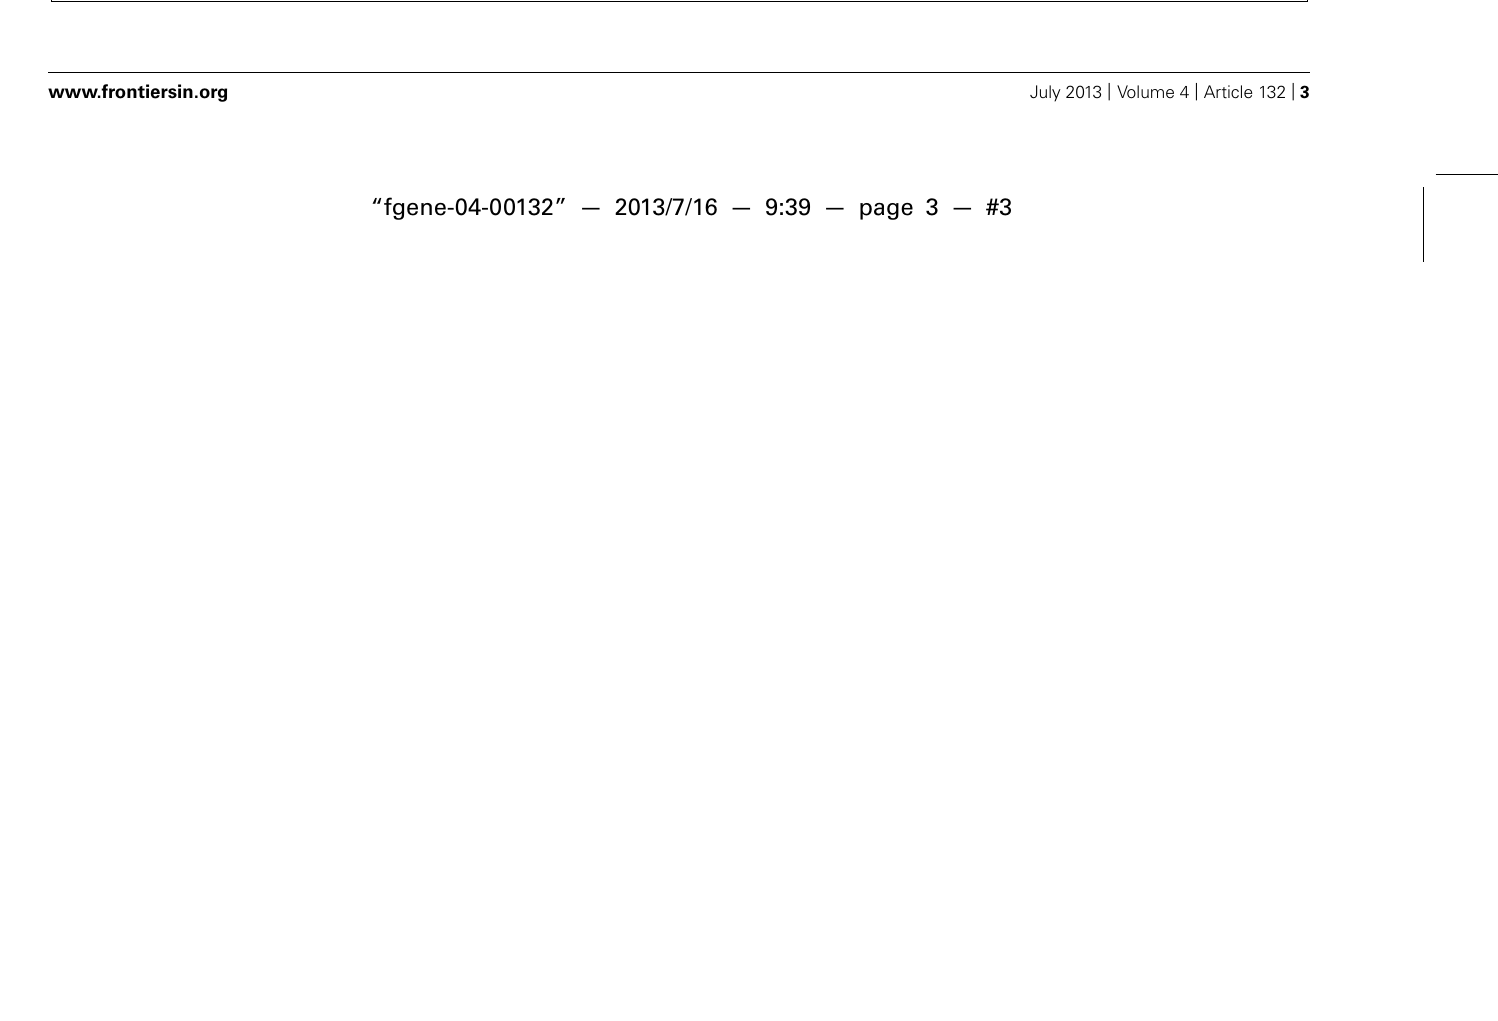
implanted blastocyst to early fetal development, and (3) transition into adult life. Genes and the environment (4) influence DNA methylation patterns at each of these